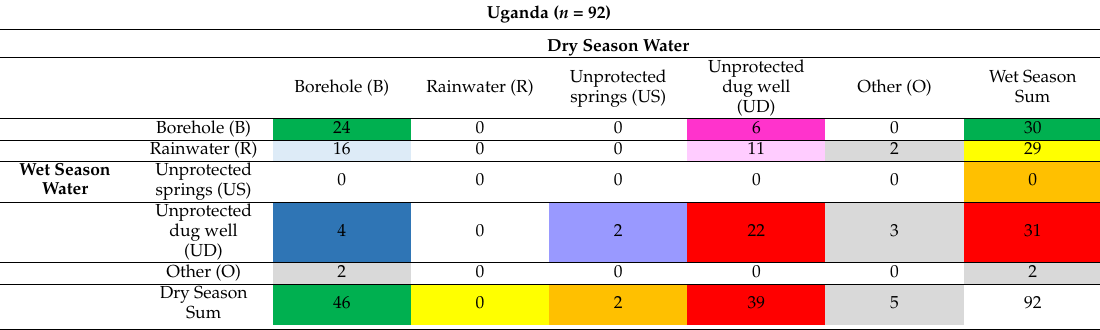
Table 3. Primary household water source type from wet to dry season and general level of risk of fecal